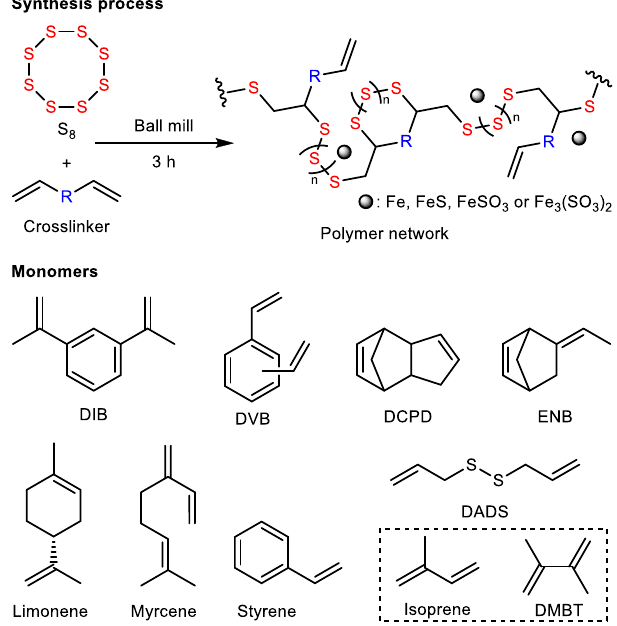
Fig. 1 | Reaction scheme of mechanochemical synthesis of inverse vulcanized polymers and monomers used. The top panel shows the synthesis process of mechanochemically synthesized inverse vulcanized polymers, and bottom panel shows all monomers used in the reactions and low-boiling point monomers are marked with dotted